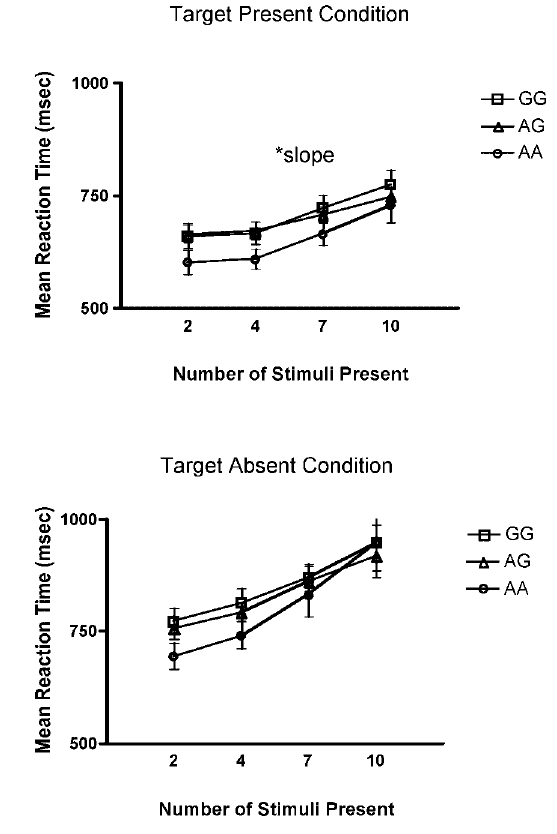
Figure 1. Mean score (SE) on psychological measures across genotype group. word pairs, F (2, 96) = 3.18, p = 0.048, and delay recall of non-related word pairs, F (2, 94) = 4.21, p = 0.02. For both immediate and delayed recall, the AA genotype group performed significantly better than the other two groups, ps <0.03 ( Figure 2 ).